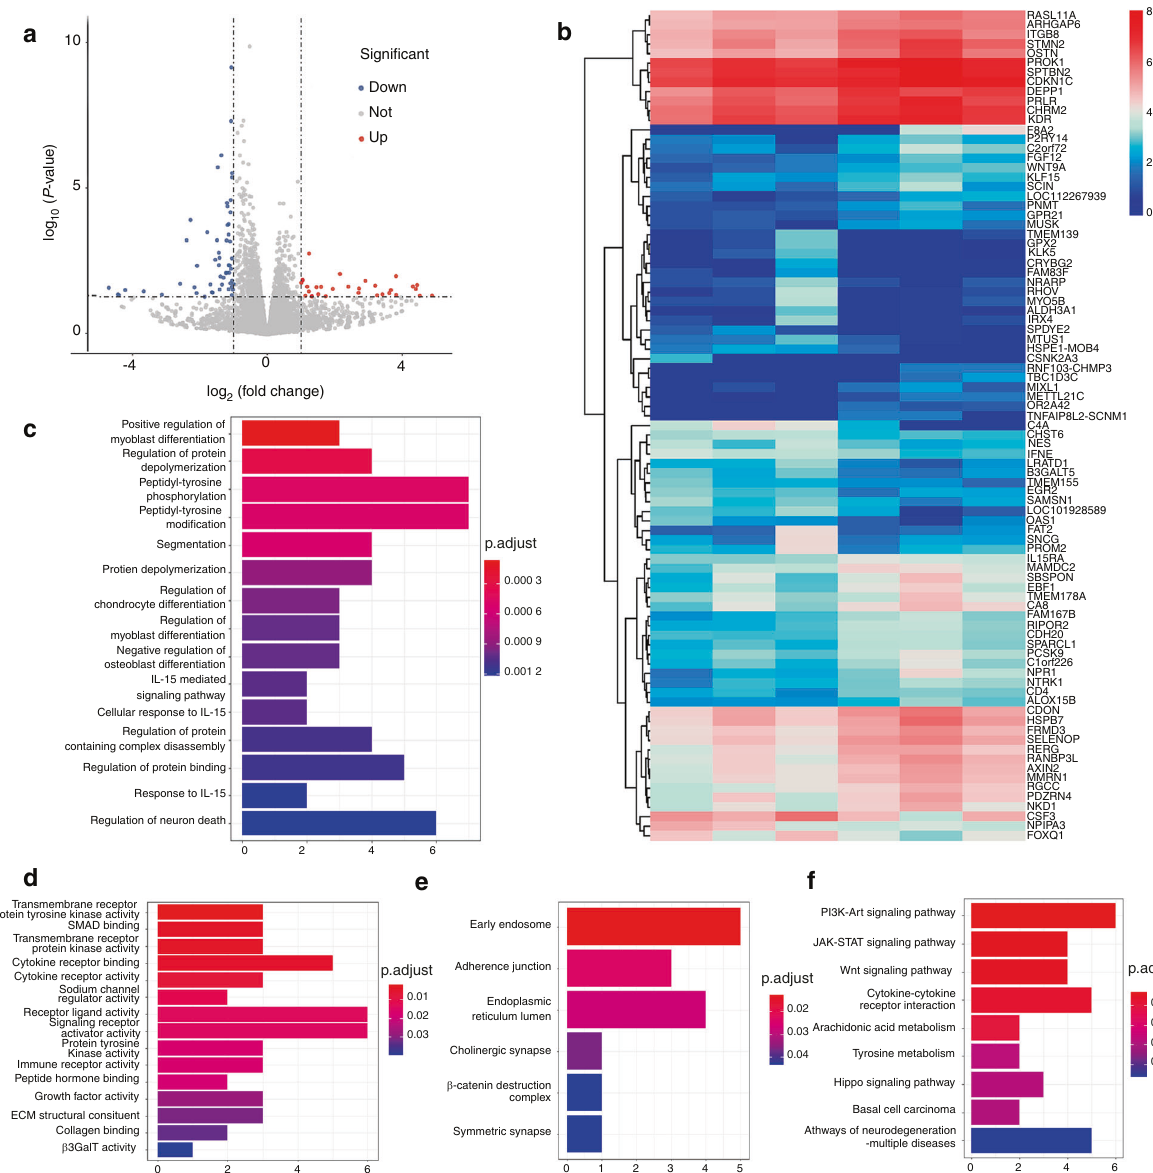
Fig. 3 Bioinformatic analysis of the effect of ZA on hMSCs after 14 days in vitro. a Volcano plot showing 16 643 genes from the RNA sequencing data. Red points represent upregulated DEGs with log 2 fold change ≥ 1 and P < 0.05. Blue points represent downregulated DEGs with log 2 fold change ≤ – 1 and P < 0.05. b Heatmap showing DEG expression levels. c GO biological process analysis of DEGs. d GO molecular function analysis of DEGs. e GO cell component analysis of DEGs. f KEGG signaling pathway enrichment analysis of DEGs ( n =